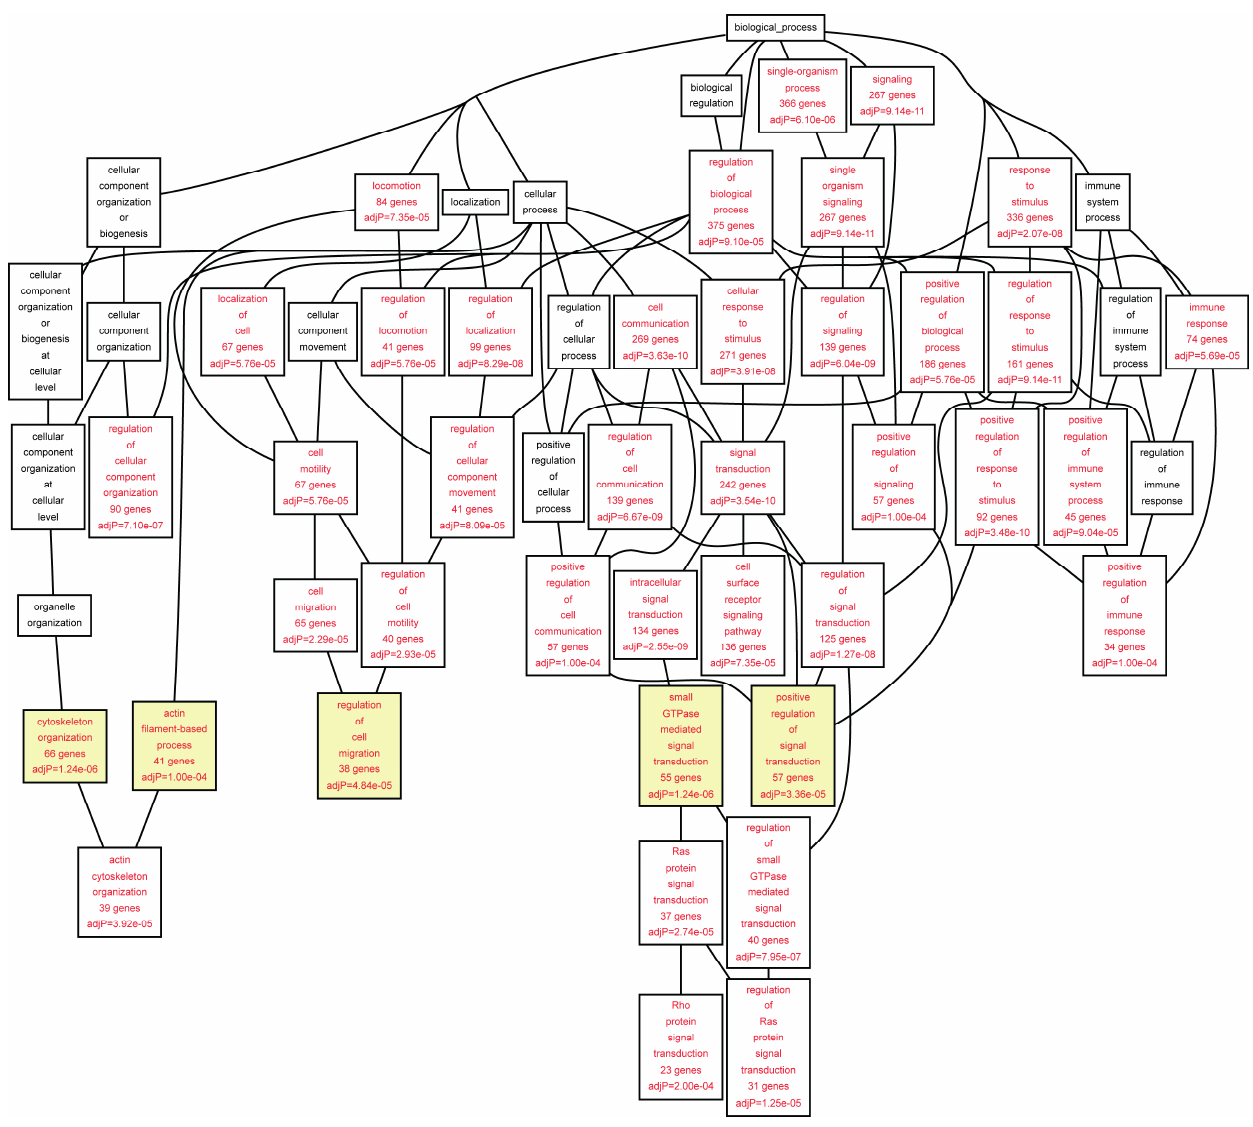
Figure 3. Biological categories of the differentially expressed target genes of transcription factors RUNX1, ELF1, ETS2 and STAT5 in the control aorta. A DAG of the GO categories of the set of 679 genes containing at least one cher in control tissue was generated by the web application WebGestalt [32]. Categories shown in red were significant (adjusted p < 0.001). The categories on the 6th level of hierarchy are discussed in the text and are shown here with a yellow background. See Tables 6 and S5 for additional